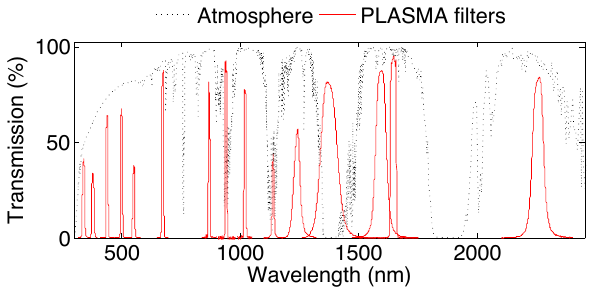
Fig. 2. PLASMA filter’s transmission.